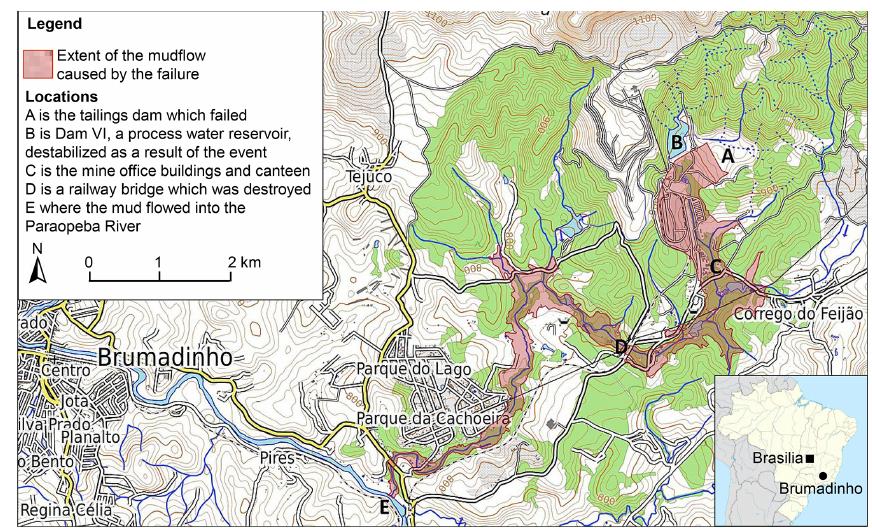
Figure 4. Location of the Brumadinho tailings dams and the extent of the mudflow (source: European Space Agency Copernicus Sentinel- 2A-L1C Satellite image and © OpenStreetMap contributors 2019; distributed under a Creative Commons BY-SA license; the image contains modified Copernicus Sentinel data 2019).